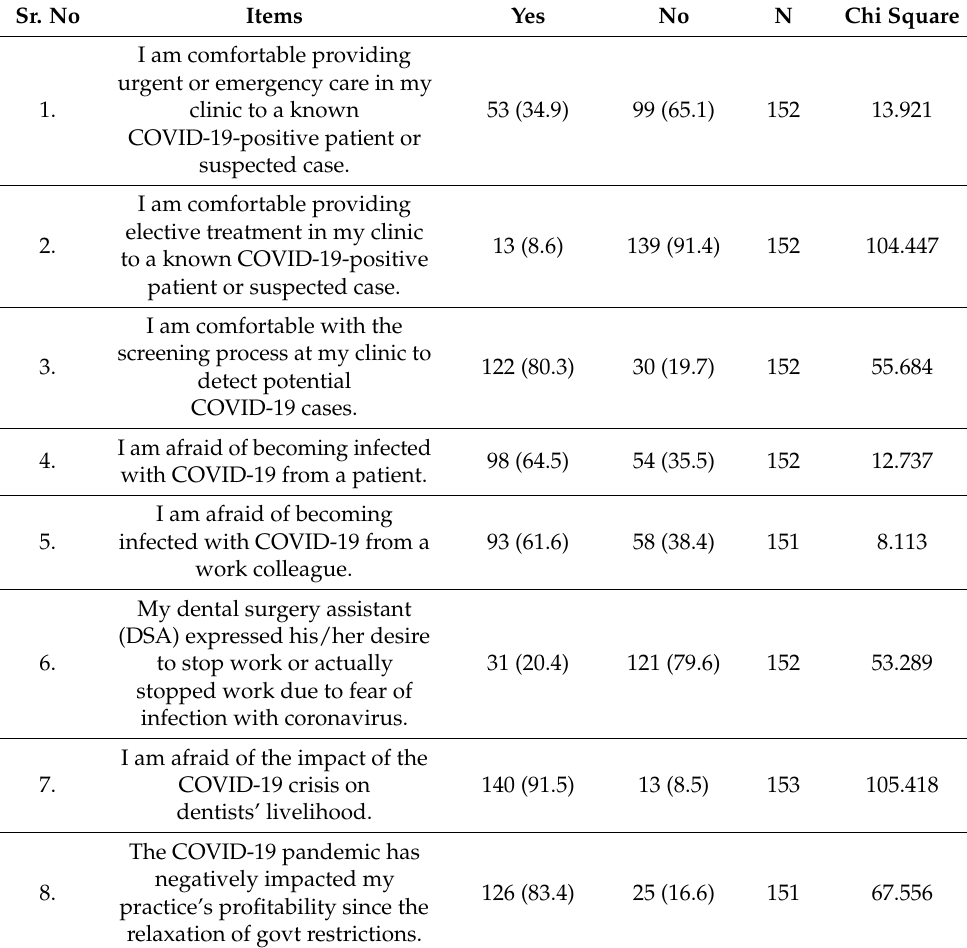
Table 2. Dentists’ Attitude toward Treatment of Patients with COVID-19 and other